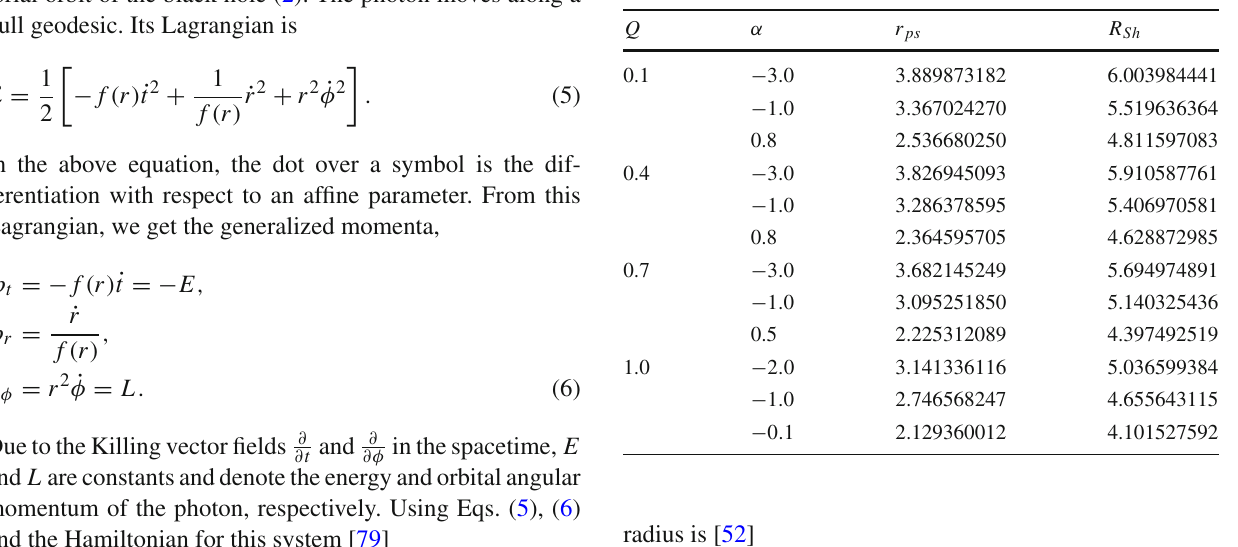
Table 1 The radii of the photon sphere and shadow under the different values of Q and